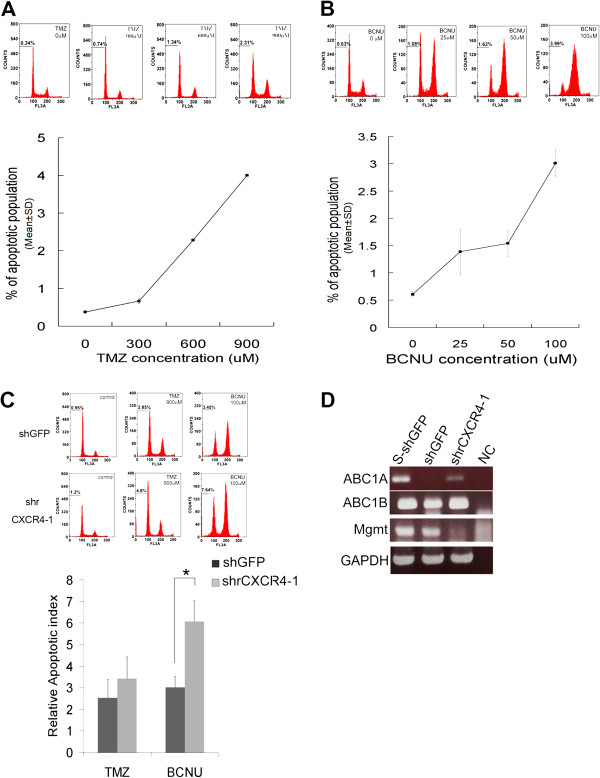
Disrupting the CXCL12/CXCR4 axis increased the sensitivity of glioblastomas to antineoplastic drugs. To investigate the effects of disruption of the CXCL12/CXCR4 axis on drug resistance, cells were plated at a density of 10 000 per well in a 12-well plate 1 d prior to drug treatment. TMZ or BCNU was added to achieve the indicated concentrations on the day of the experiment. After 24 h, cells were collected, fixed, stained with propidium iodide (PI) according to standard protocols, and analyzed. The histograms of flow cytometry showed that the RG2 cells were highly resistant to TMZ (A), but only slightly resistant to BCNU (B). Two independent experiments were done in triplicate and yielding similar results. As shown is the representative from one experiment. (C) Under normal-medium conditions, both shGFP and shrCXCR4 were treated with 900μM of TMZ or 100 μM of BCNU. PI staining revealed that the disruption of CXCR4 significantly increased the susceptibility of RG2 to BCNU, but only slightly increased its susceptibility to TMZ. The apoptotic index was defined as the fold of the apoptotic population of treated cells compared with the apoptotic population of vehicle-treated cells. Two independent clones of siGFP and shrCXCR4 were used to perform the experiments, yielding similar results. Each clone was used to perform 2 independent experiments in triplicate. (*t test, P < 0.05). (D) RT-PCR indicated that disrupting CXCR4 disturbed the expression of genes associated with drug resistance in GSCs.